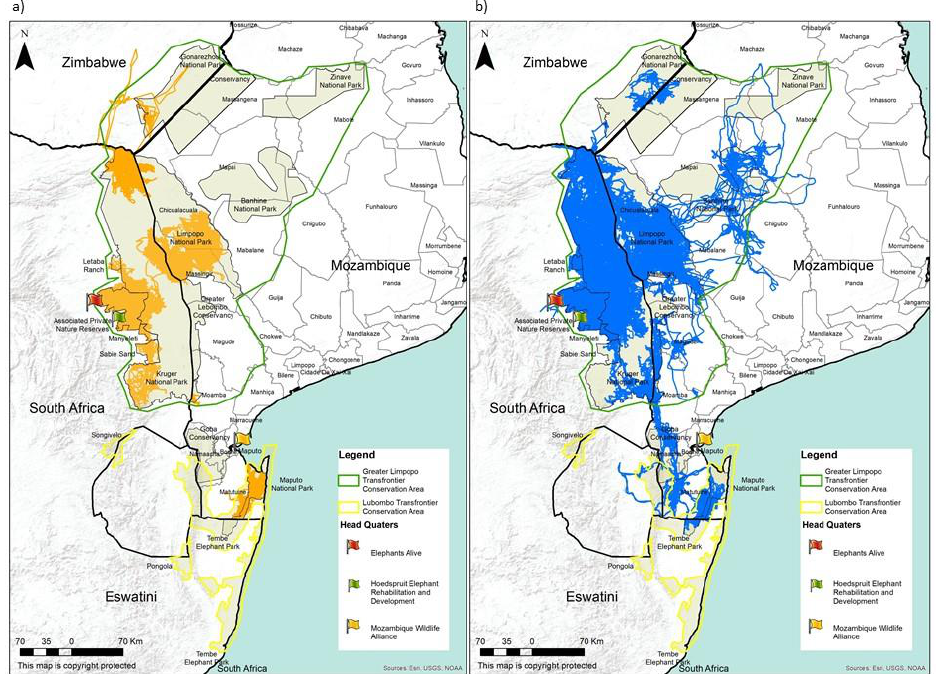
Figure 2. The transboundary movements of elephants between South Africa, Mozambique and Zimbabwe. A total of 38 cows from family units have been collared over time with the first cows ( a ) collared in 2004 in the Associated Private Nature Reserves (APNR) to the west of the Kruger National Park (KNP). In 2008–2012 elephant cows were collared in the Makuleke Concession in the northern regions of the KNP. In 2016–2021 cows were collared in Limpopo National Park (LNP) and in 2019–2022 in Maputo Special Reserve in Mozambique. The first two cows were collared outside of protected areas (PAs) in 2022. Of the 102 bulls collared over time, the first ( b ) bulls were collared in 1998 in the APNR, with seven bulls collared on the eastern border of the KNP in 2006. Bulls were also collared from 2008–2012 in northern KNP. The first bulls were collared in LNP in 2016–2021 and in Banhine National Park in 2019. The first bull was collared outside of PAs in Mozambique in 2018. In total 140 elephants have been collared over time, not including any recollaring events. The headquarters of the three collaborating entities are shown, with Elephants Alive (red flag) and Hoedspruit Elephant Rehabilitation and Development (green flag) based in South Africa while the Mozambique Wildlife Alliance (yellow flag) is based in Mozambique. The various protected areas that form part of two Transfrontier Conservation Areas (TFCAs) are outlined in green for Great Limpopo Transfrontier Conservation Area and yellow for Lubombo Transfrontier Conservation